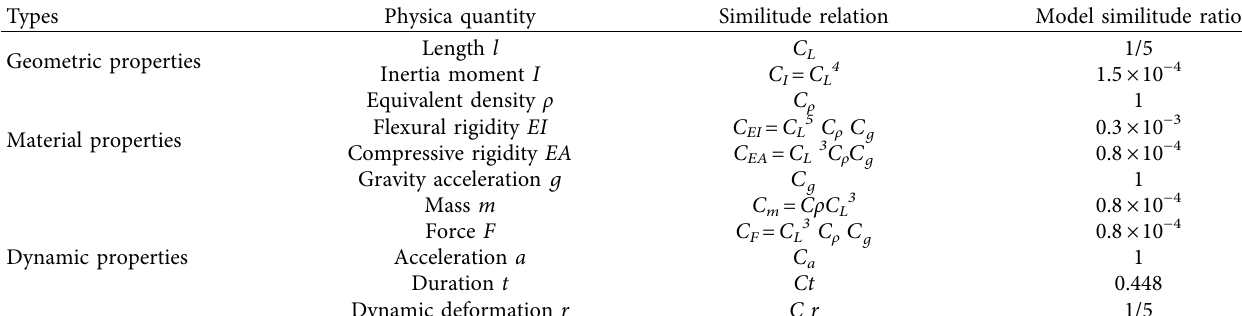
Table 1: Similitude ratio of model structure and model soil.